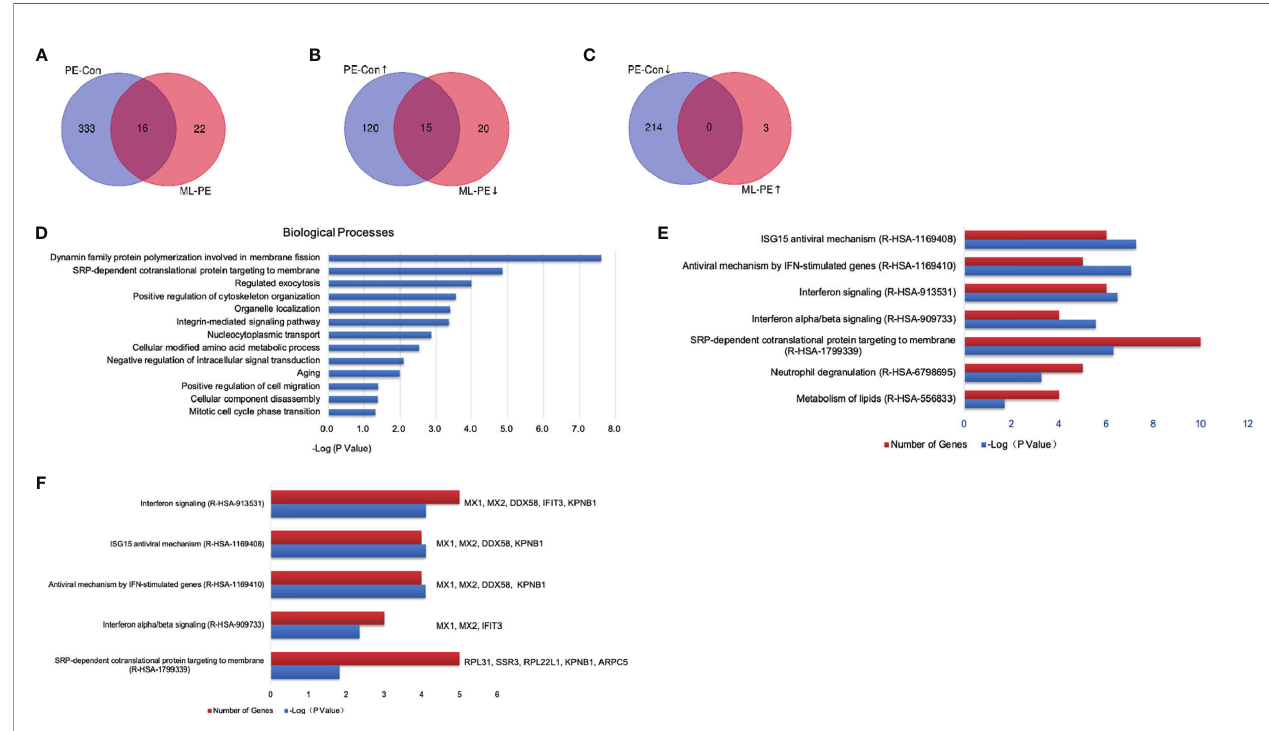
FIGURE 7 | Comparison and enrichment analysis of DEPs identi fi ed among Control, PEDV and ML + PEDV groups. (A) The total number of DEPs in the PEDV vs Control (PE-Con) and ML + PEDV (ML-PE). The overlap indicated the number of common DEPs identi fi ed both in the PE-Con and ML-PE groups. (B) The total numbers of upregulated DEPs in the PE-Con group and downregulated DEPs in the ML-PE group. The overlap indicated the numbers of common DEPs that were upregulated in the PE-Con group and downregulated in the ML-PE group. (C) The total numbers of downregulated DEPs in the PE-Con group and upregulated DEPs in the ML-PE group. The overlap indicated the numbers of common DEPs that were downregulated in the PE-Con group and upregulated in the ML-PE group. (D) Enriched biological processes (A, E) the top 5 enriched Reactome pathways of the DEPs between the PEDV group and the ML + PEDV group. (F) Biological process enrichments for the DEPs which were reversely regulated by ML administration. ↑ , upregulated; ↓ ,